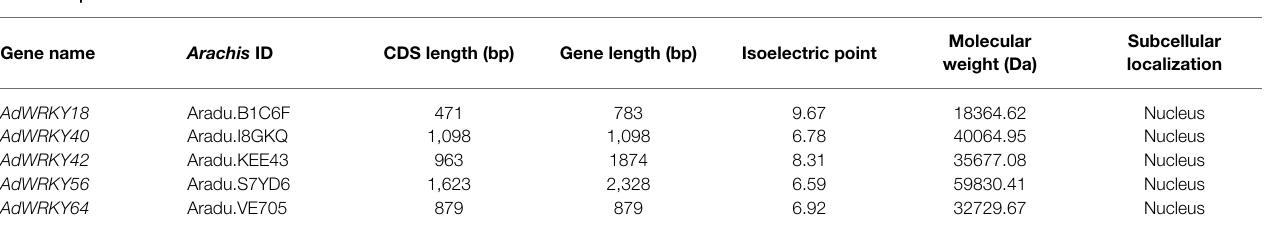
TABLE 1 | AdWRKYs